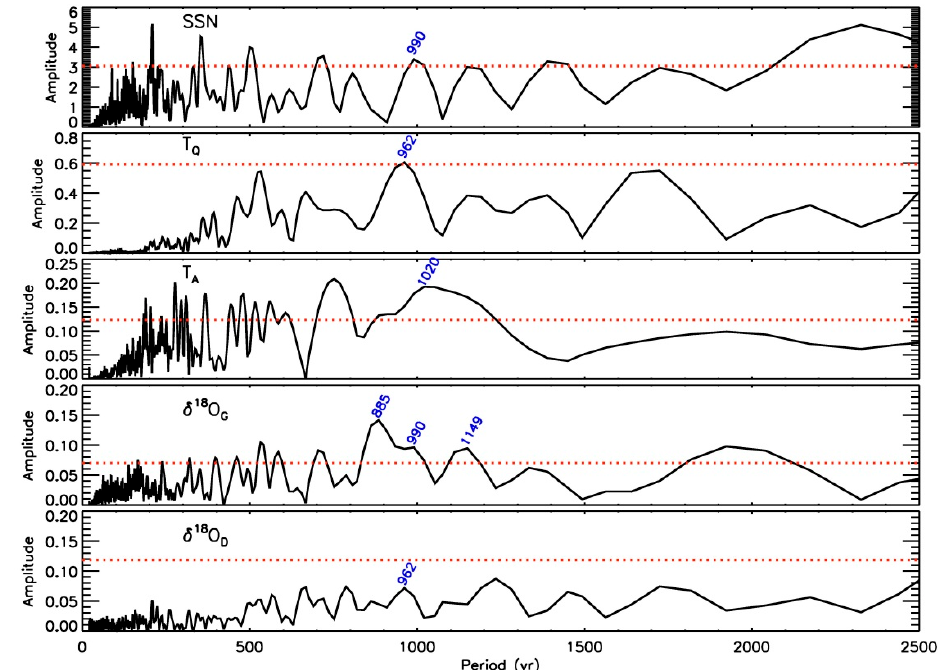
Figure 1. The Lomb-Scargle periodograms of SSN and climate indices (temperatures and δ 18 O proxies) on Earth during the study interval (BC 6755–AD 1885). The red horizontal dotted lines denote the 95% confidence levels. Period is in unit of year